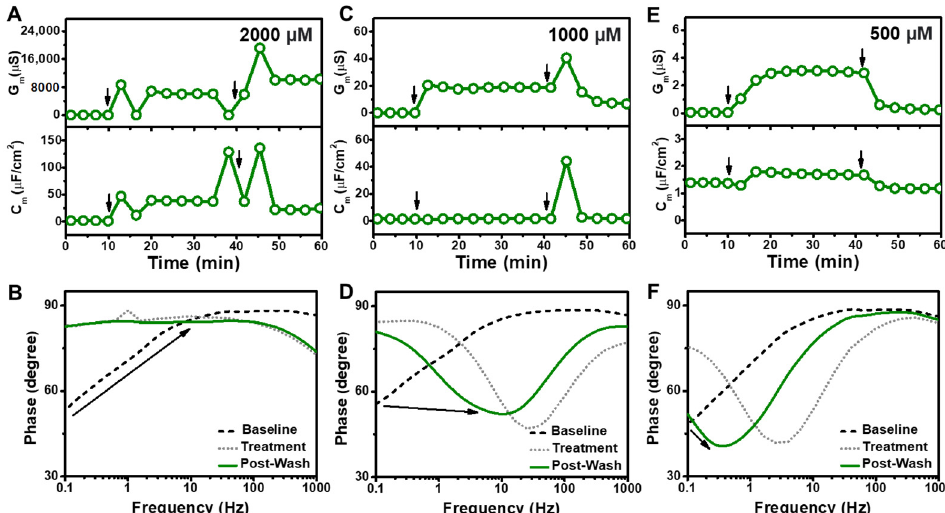
Figure 4. ( A ) Time-resolved conductance (G m ) and capacitance (C m ) shifts upon 2000 µM SDS addi- tion to the tBLM platform. The arrows indicate compound addition at t = 10 min and buffer washing at t = 40 min, respectively. ( B ) Bode plots for 2000 µM SDS addition to the tBLM platform, whereby baseline, treatment, and post-washing reflect the initial measurement signal, signal after compound addition, and signal after buffer washing, respectively. Corresponding data for ( C , D ) 1000 µM SDS and ( E , F ) 500 µM SDS addition to the tBLM platform.